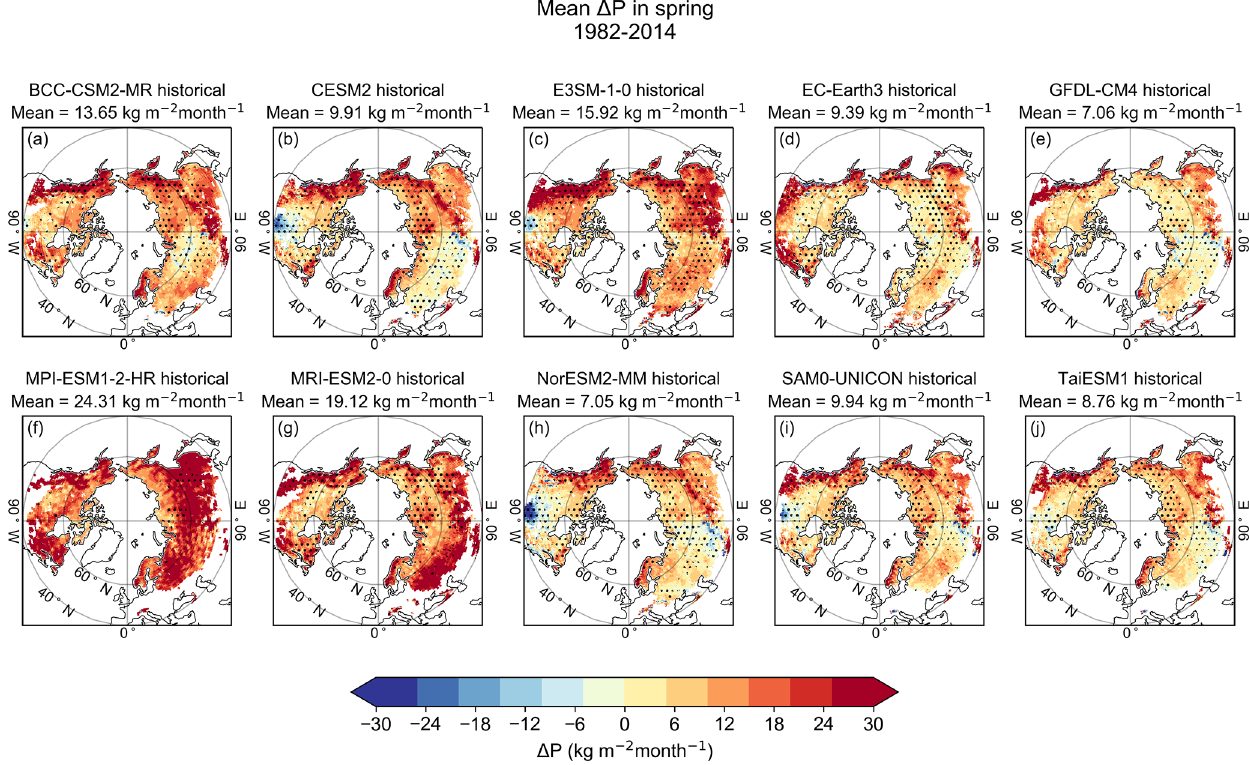
Figure 9. The mean model bias in P ( (cid:49)P , model minus observation) in snow-covered areas in spring 1982–2014. The dots indicate areas where models either overestimate both SWE change and P or underestimate both SWE change and P